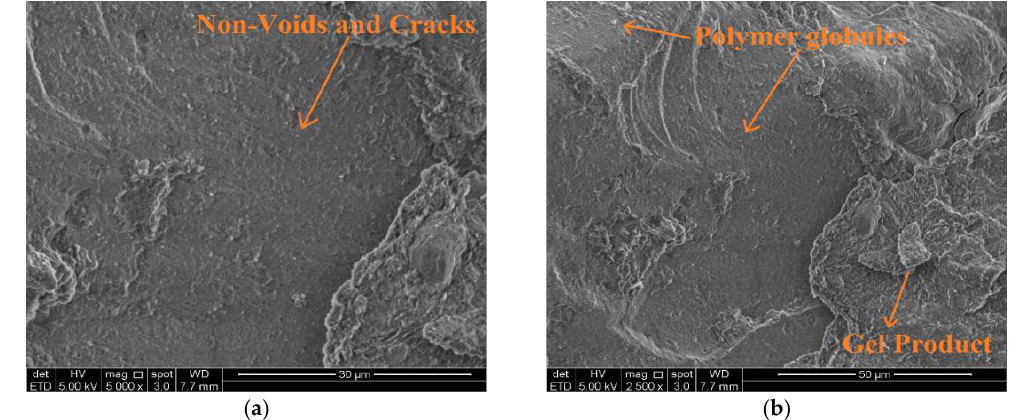
Figure 10. ( a , b ) SEM images of the soil treated by caltite with cement after 28 days of curing pe- riod.